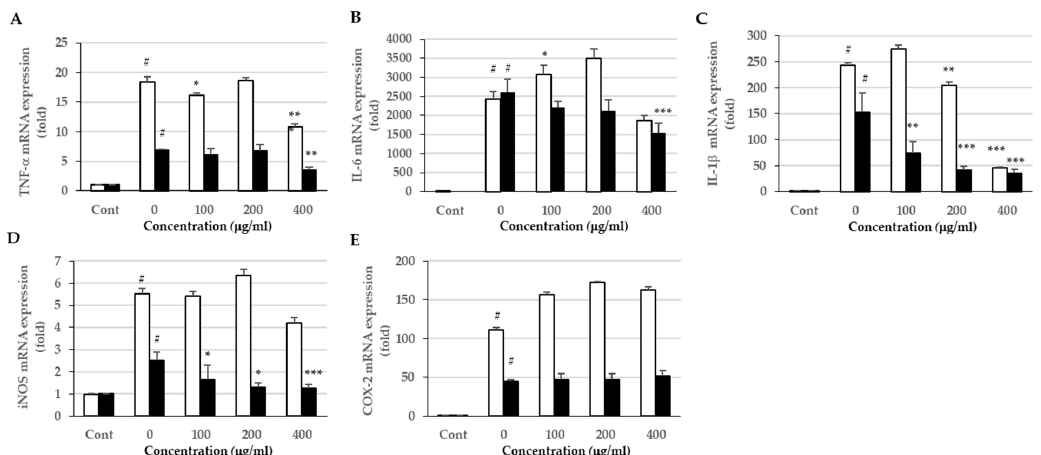
Figure 2. Effects of the extracts on ( A ) TNF- α , ( B ) IL-6, ( C ) IL-1 β , ( D ) iNOS, and ( E ) COX-2 expression in LPS-stimulated RAW 264.7 macrophages. Total RNA was extracted and analyzed for mRNA expression. White bar represents P. granatum , black bar represents P . Guajava. (Significant versus the non-treated control, # p < 0.001, Significant versus LPS treatment, * p < 0.05, ** p < 0.01 and *** p < 0.001.)